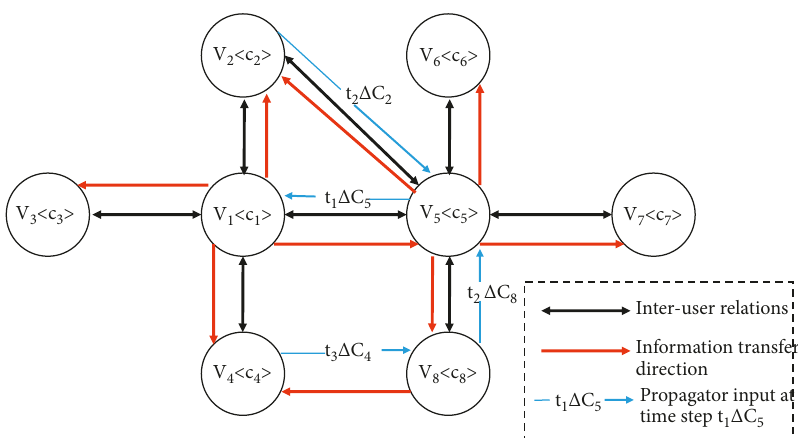
Figure 4: Information dissemination process of blockchain social